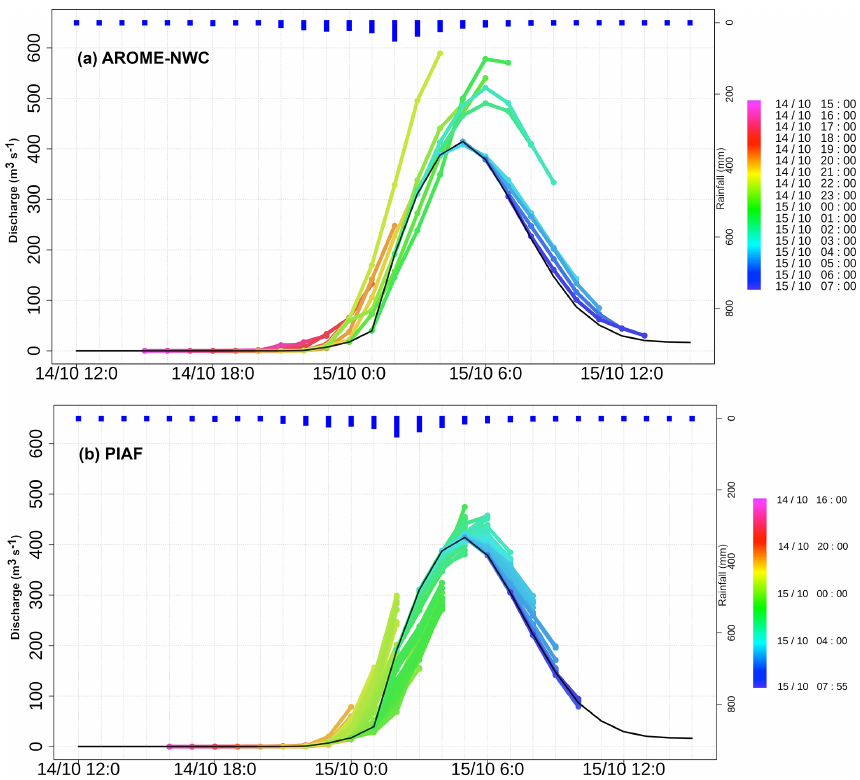
Figure 11. Discharge time series simulated by ISBA-TOP driven by ANTILOPE (black curve), by (a) AROME-NWC and by (b) PIAF for the case 15 October 2018 for the Orbiel river at Bouilhonnac (watershed No. 4). The reverse histogram represents the ANTILOPE hourly rainfall averaged over the